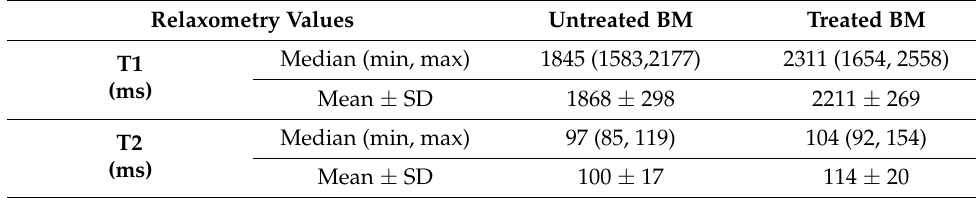
Table 3. T1 and T2 values in patients from the untreated and treated